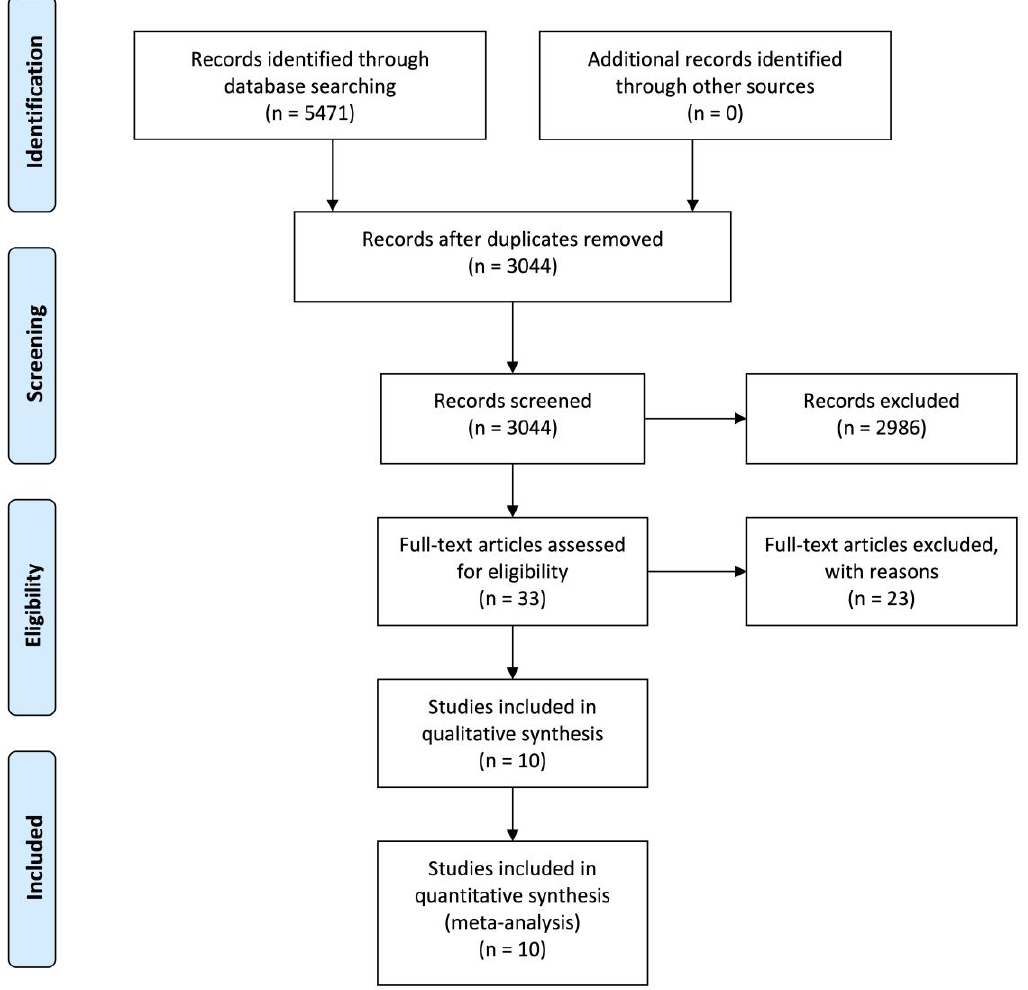
Figure 1. Flow diagram for paper selection.